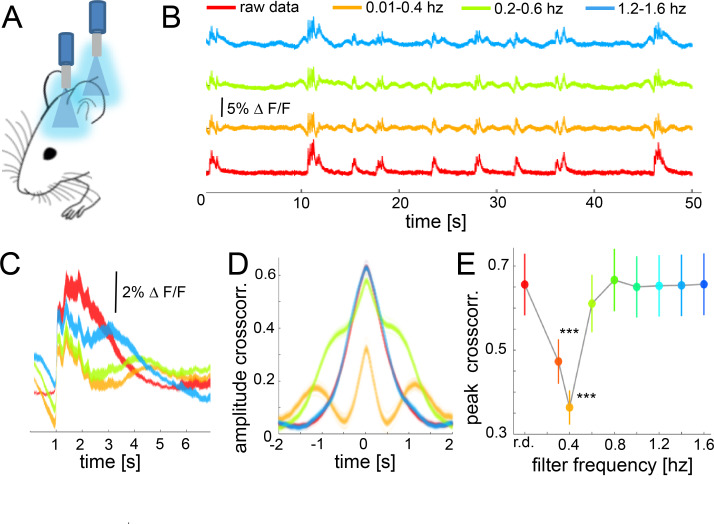
During slow wave activity, the correlation between distant optical recordings is driven by slow-wave-associated calcium waves.(A) Schematic of fiber photometry in cortical areas S1 and V1. (B) Exemplary fluorescent signal trace recorded from V1 filtered at different band-stop intervals, excluding those particular intervals from the recordings. (C) Mean of the down-up transitions for a trace (∆f/f) at different band stop filters. It can be observed how the amplitude, length and size of the slow waves are modified at each filtered bandwidth. (D) Cross-correlation results of a single recording filtered at different band-stop intervals (color code is the same than in subplot B). (E) Average of the cross-correlation peak values (n = 6) at different band-stop intervals, ***p<0.001 (Paired t-test, n = 6).